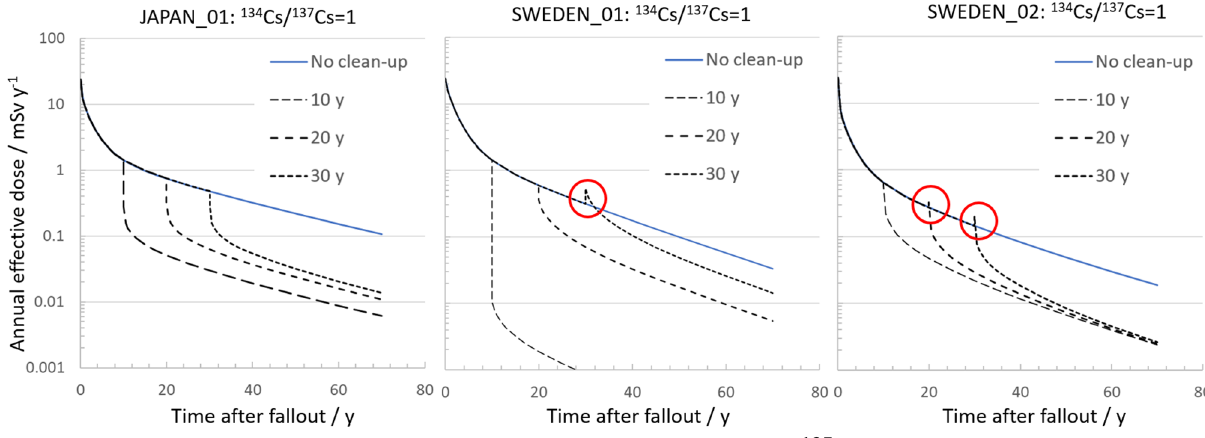
Figure 5. Time pattern of external effective dose rate per unit 137 Cs deposition ((mSv y −1 )/(MBq m −2 137 Cs) for indoor occupancy in residential wooden houses for the three different soil migration settings and for a 134 Cs/ 137 Cs ratio of 1, for various time delays to cleanup, t cleanup with 5 cm topsoil removal. The cases with tardy scraping effects are highlighted with red circles.